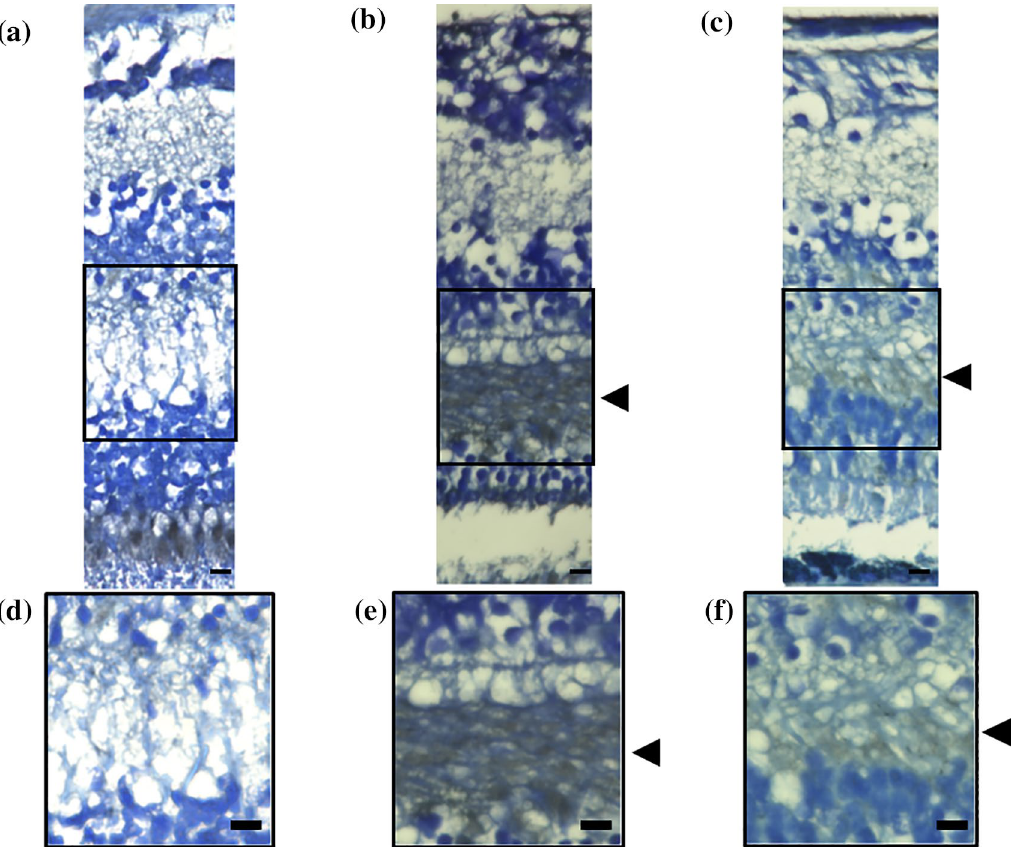
Figure 4. Location of protein S in the human retina with and without diabetes. The retina of post-mortem human eyes was stained with a PS antibody. No staining was observed in the retina from patients without DM (62-years-old, woman, ( a ). PS is present in the OPL of patients with DM ( b , 93-year-old, man with NPDR; 60-year-old, man with PDR). Black arrow heads shows localization of PS on OPL. Magnified images of each images were shown ( d – f ). DM, diabetes mellitus; NPDR, non-proliferative diabetic retinopathy; OPL, outer plexiform layer; PDR, proliferative diabetic retinopathy; PS, protein S. Bar: 10 μm.